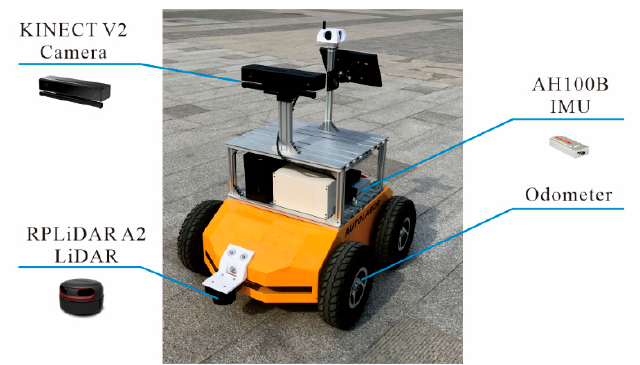
Figure 2. The experimental platform: Autolabor.